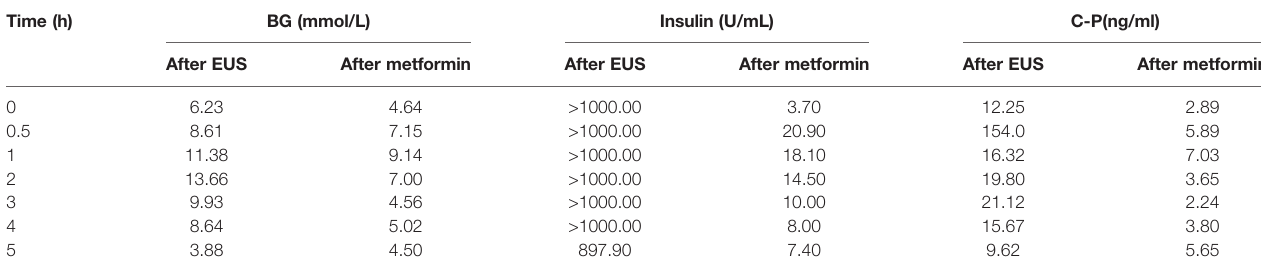
TABLE 2 | Results of the OGTT review after performing EUS-FNA and after oral metformin. Time (h) BG (mmol/L) Insulin (U/mL) After EUS After metformin